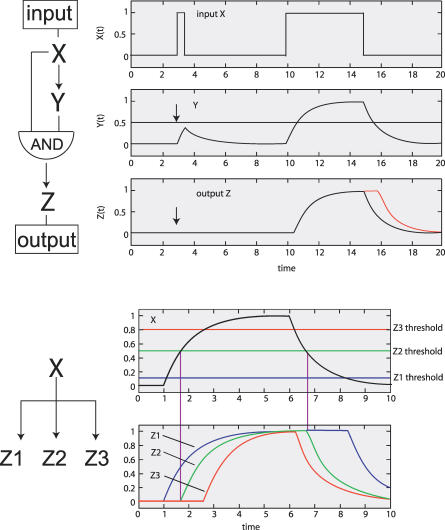
Dynamic Properties of Network Motifs(Upper panels) Shows a feed-forward loop, where Y is an accumulation of X over time, and the product of X and Y passes a threshold (thin horizontal line) to activate Z. This loop rejects impulsive perturbations in X, and responds only to persistent activation. This is because Y increases gradually to pass the threshold. A similar rejection of impulsive fluctuations can be achieved by a feed-forward chain, where X activates Y and Y activates Z. However, a feed-forward chain responds slower (thin red curve) to the off signal than to the loop.(Lower panels) Shows a single-input motif, where X regulates Z1, Z2, and Z3 (n = 3). When X changes over time, Z1, Z2, and Z3 are activated and deactivated in order, based on their thresholds. In particular, Z1, which has the lowest threshold, is activated first and deactivated last. (Reproduced from [12].)